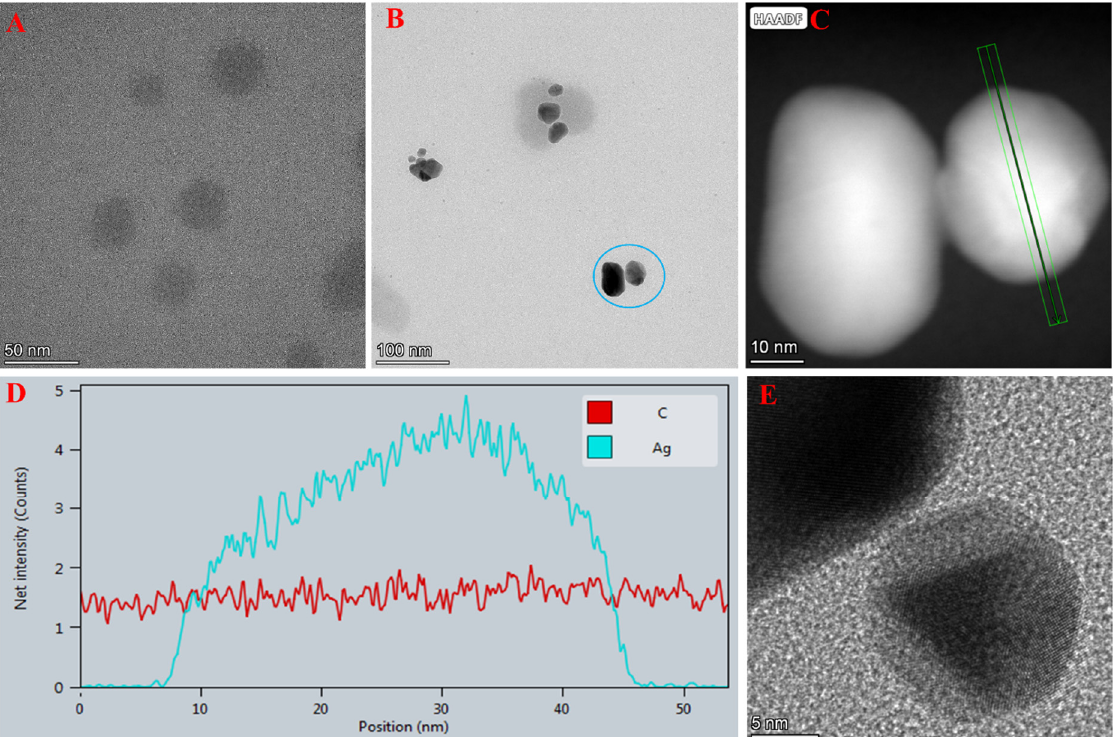
Figure 1. ( A ) TEM image of the N-CQDs. ( B ) TEM image of the AgNPs/N-CQDs. The part of bule circle was further detected by HAADF and showed in ( C ). ( C ) Regular HAADF image of the AgNP/N-CQDs. ( D ) EDS line scan of the AgNPs/N-CQDs. ( E ) HRTEM images of the AgNPs/N- ( D ) EDS line scan of the AgNPs/N-CQDs. ( E ) HRTEM images of the CQDs.